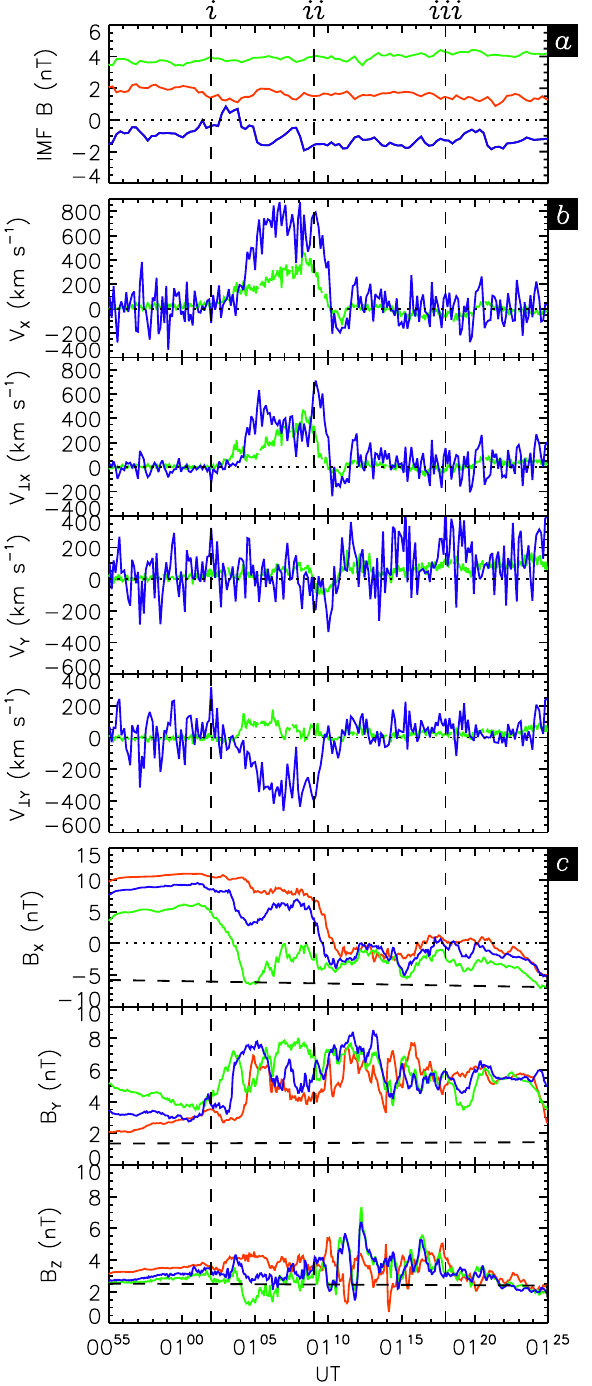
Fig. 5. Time series data from 00:55–01:25 UT on 17 September 2005 in the same format as Fig.